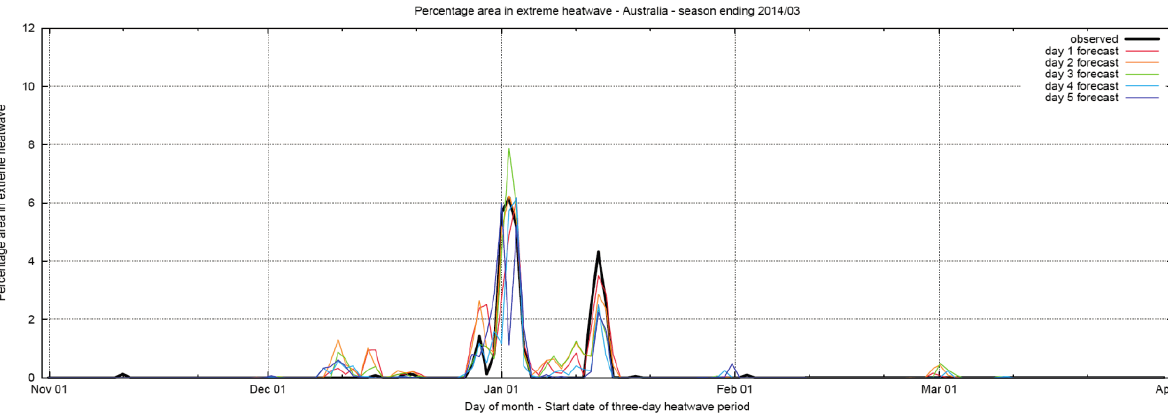
Figure A4. As per Figure A2 but for percentage area in extreme